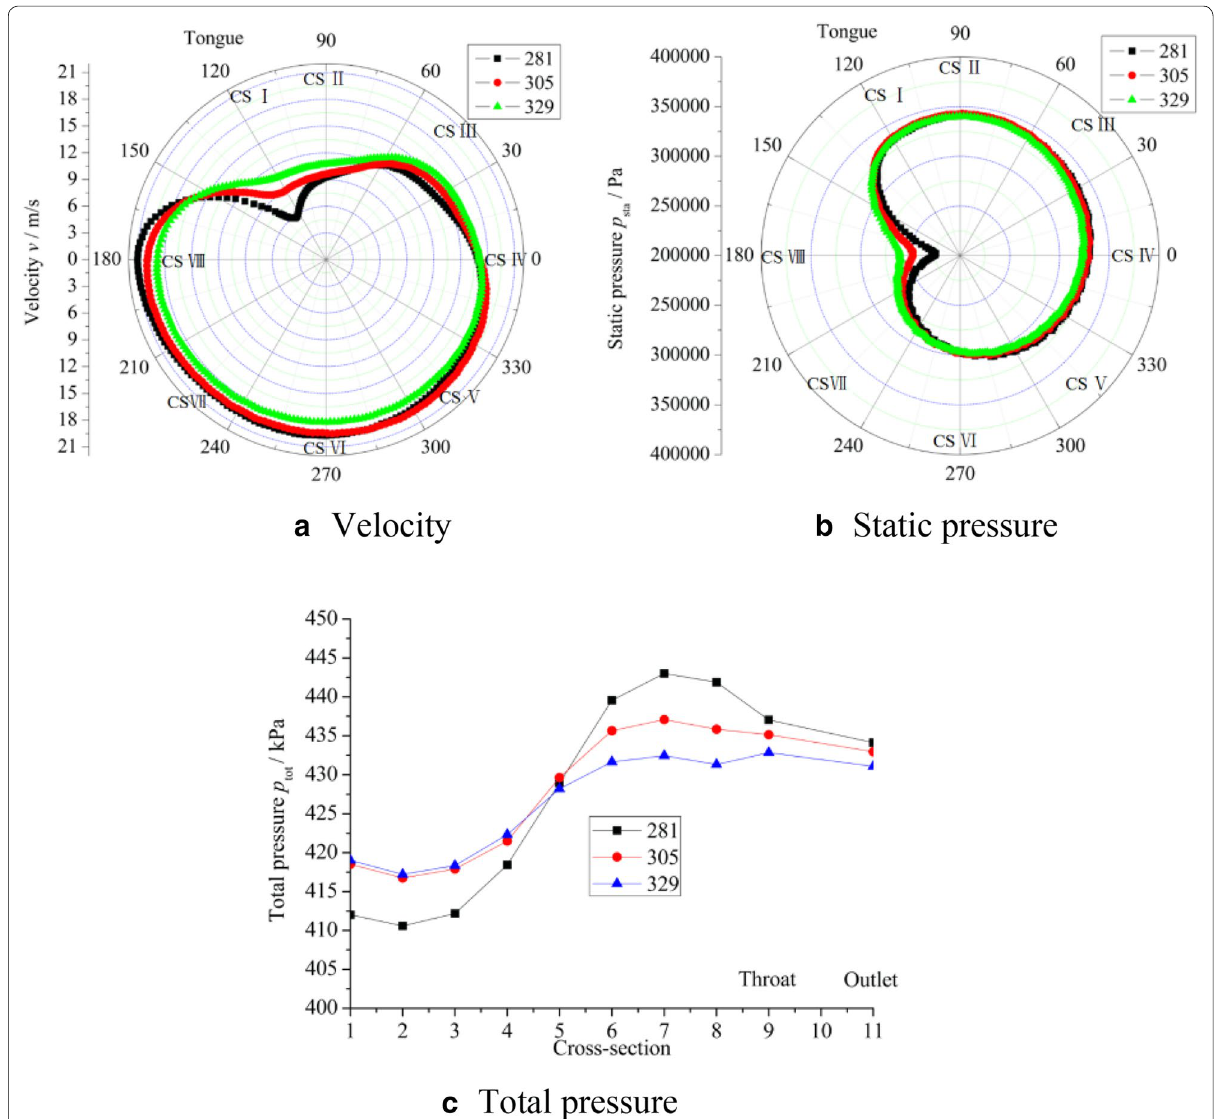
Figure 8 Distribution of pressure and velocity in volute casing at nominal flow rate